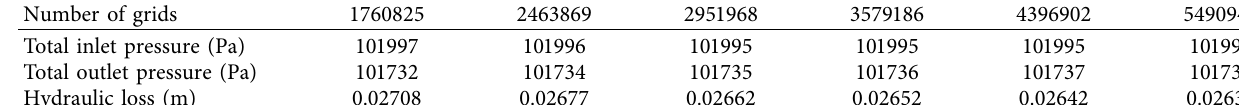
Table 1: Calculation results of hydraulic loss under different grid numbers.